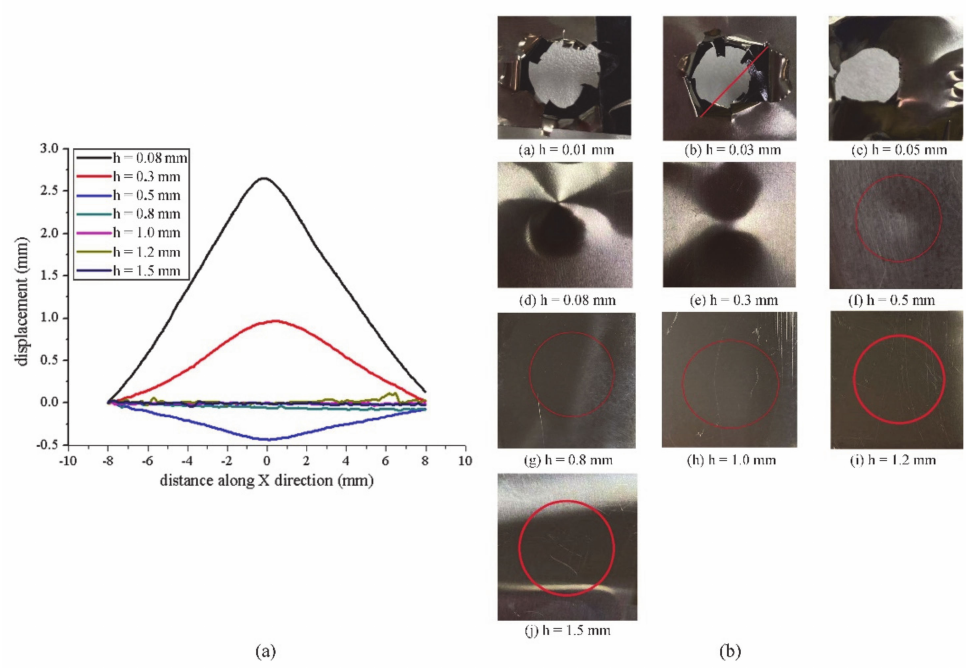
Figure 2. ( a ) The outline of targets with different thicknesses. ( b ) The morphologies of target material with different